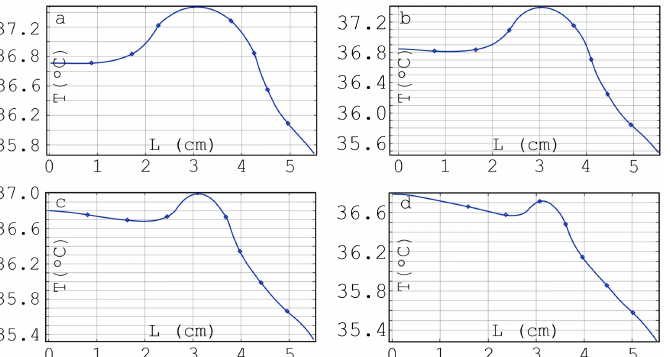
Figure 17. Distributions of thermodynamic temperature over depth for tumors of different radii R at Q ( can ) = 3 × 10 4 W m − 3 : ( a ) R = 1 cm, ( b ) R = 0.75 cm, ( c ) R = 0.5 cm, ( d ) R = 0.35